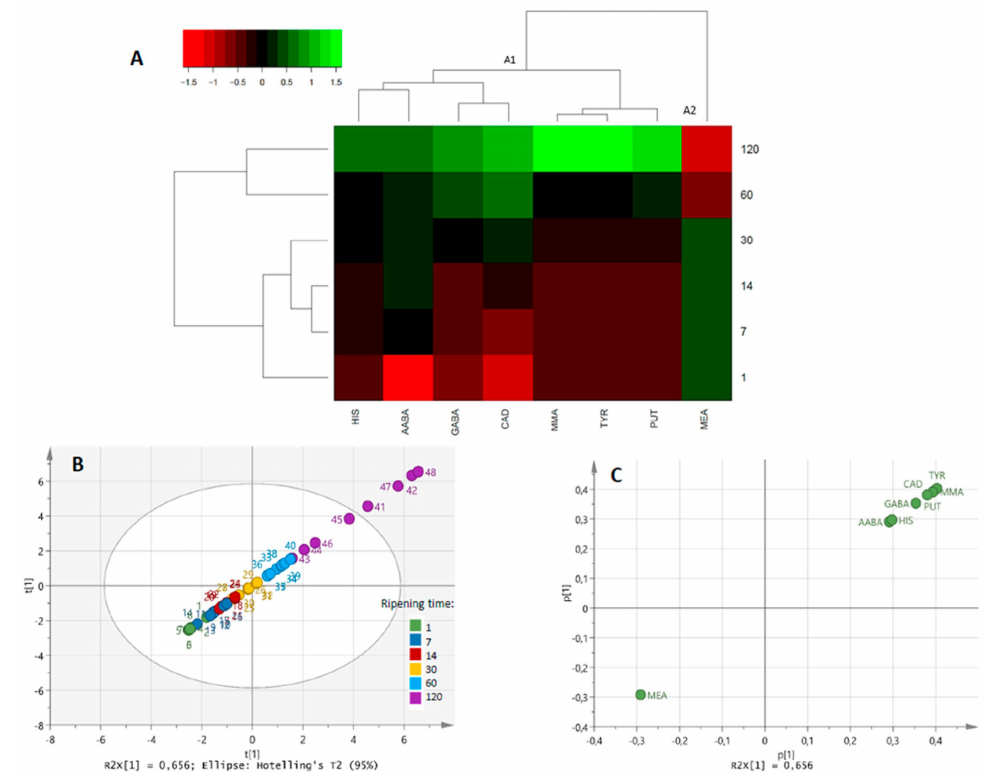
Figure 3. HCA ( A ) and scores and loadings plots of PCA ( B and C , respectively) of the identified BAs during ripening (1, 7, 14, 30, 60 and 120 days) of Idiazabal cheese. The scale values of the HCA correspond to log-transformed and UV scaled